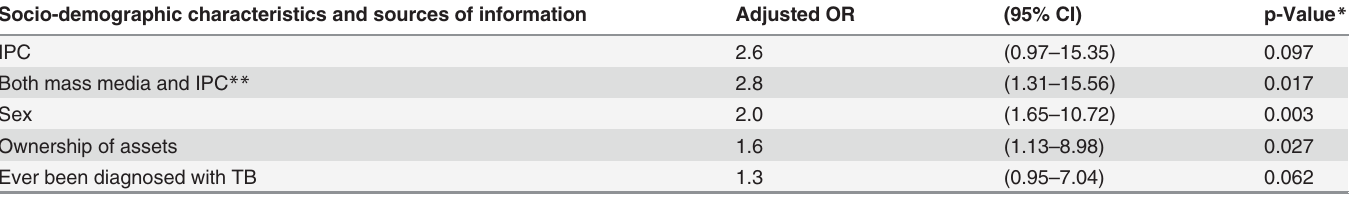
Table 3. Factors associated with risk perceptions of tuberculosis: Sources of information while adjusting for sex, ownership of assets and ever been diagnosed with TB. Socio-demographic characteristics and sources of